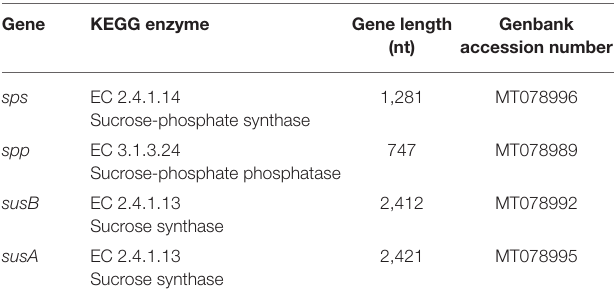
TABLE 2 | Genes encoding trehalose biosynthetic enzymes in Chroococcidiopsis sp. CCMEE 029.